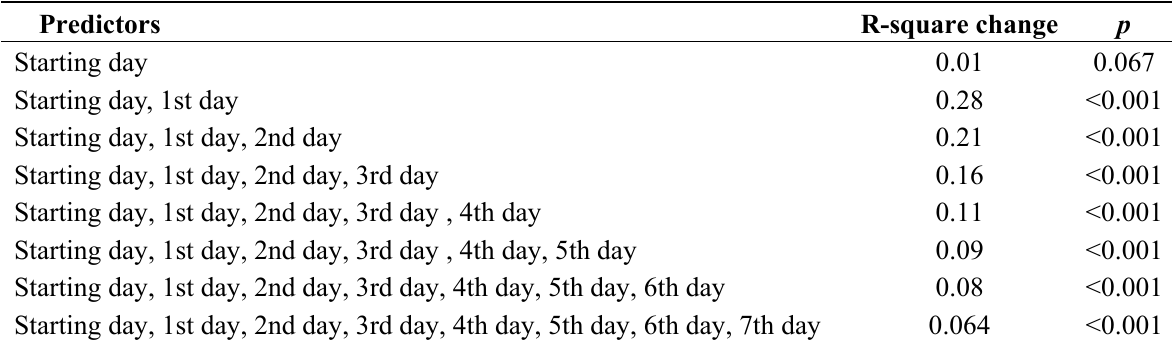
Table presented R-squared change from the hierarchical regression analysis; dependent variable is weekly step counts; p —significance F change from hierarchical